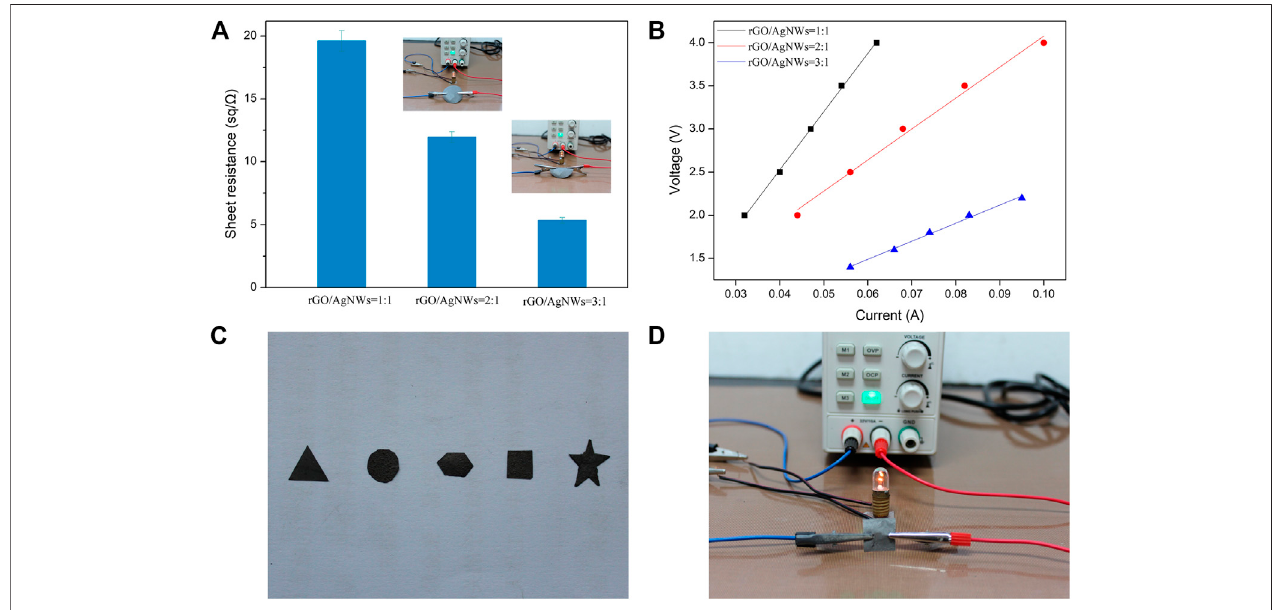
FIGURE5| Sheetresistance (A) andI-Vcurve (B) ofrGO/AgNWspaper,thedifferentpatternsofrGO/AgNWspaper (C) andadigitalphotographofthelightedLED lamp of patterned rGO/AgNWs paper (D) .